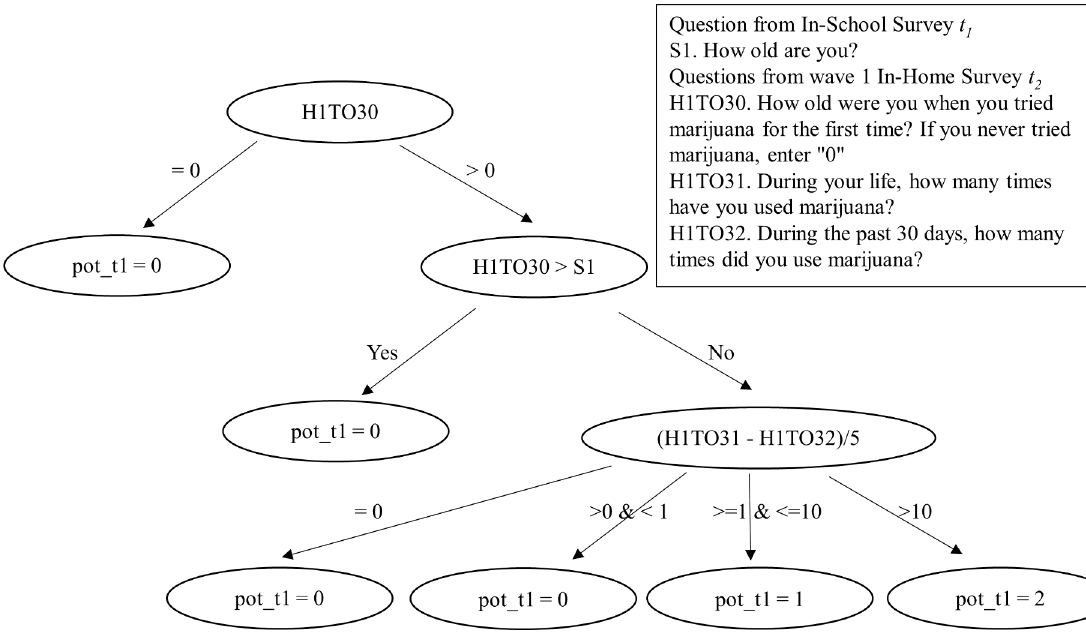
Fig 2. Reconstruction of marijuana use measure at t 1 (In-School